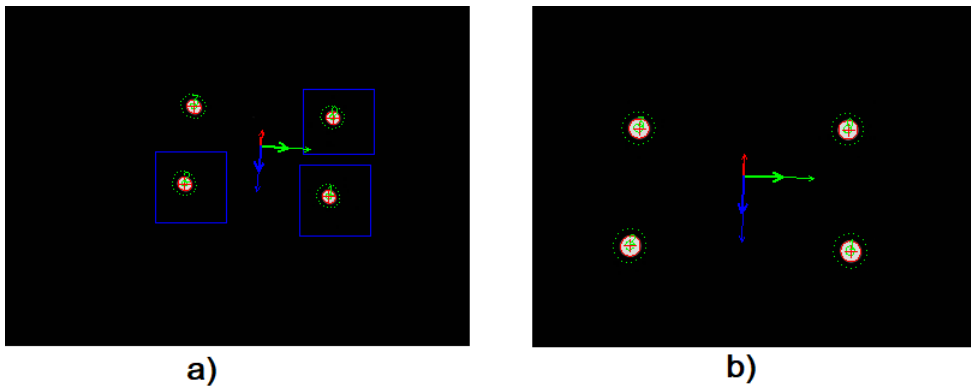
Figure 19. The two following robots look at the leading robot. ( a , b ) illustration of 4 LED detection by robot follower 1 and 2,